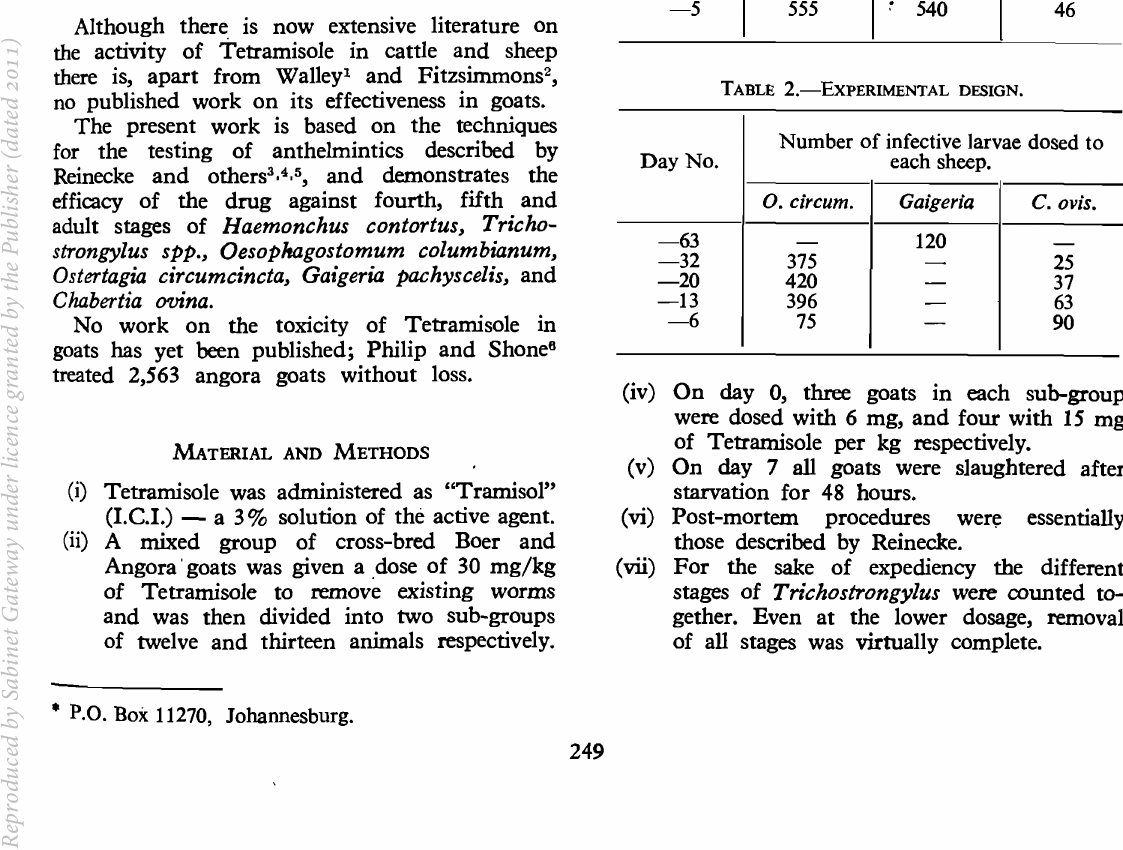
TABLE I.-EXPERIMENTAL DESIGN. Day No, Number of infective larvae dosed to each sheep.